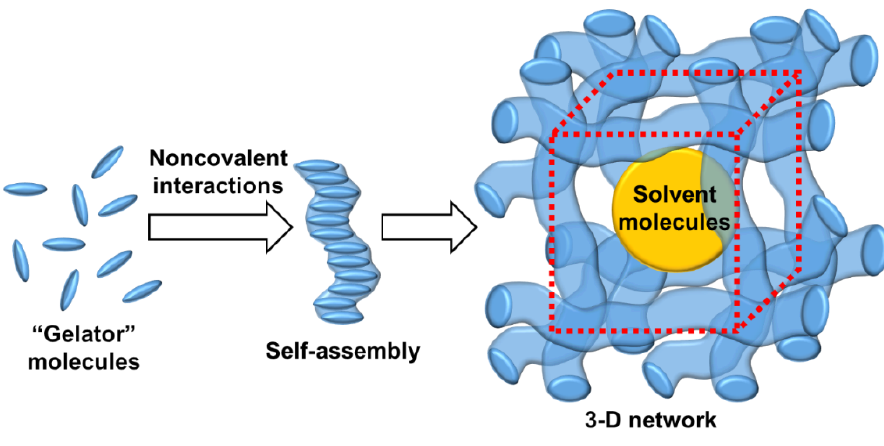
Figure 44. The formation of supramolecular